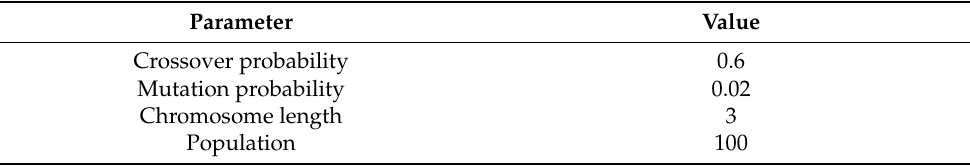
Table 2. Genetic algorithm